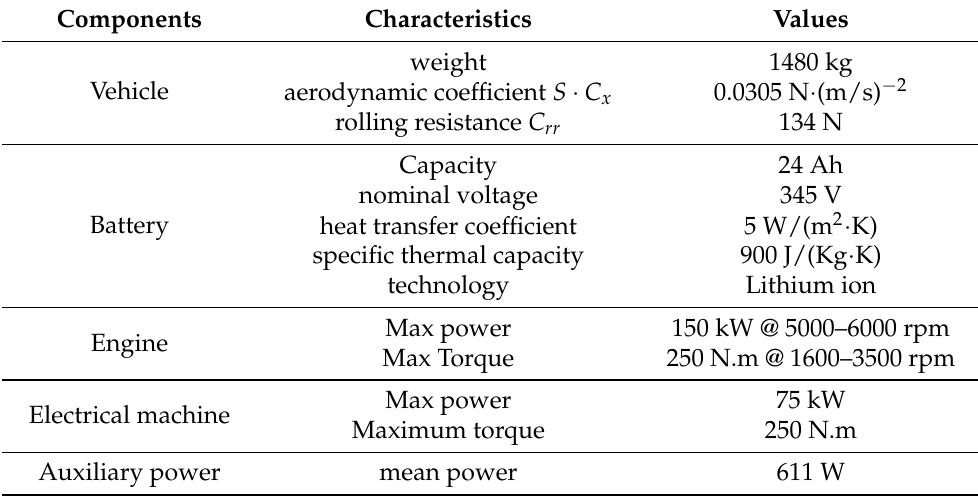
Table 3. PHEV—Golf GTE main characteristics.